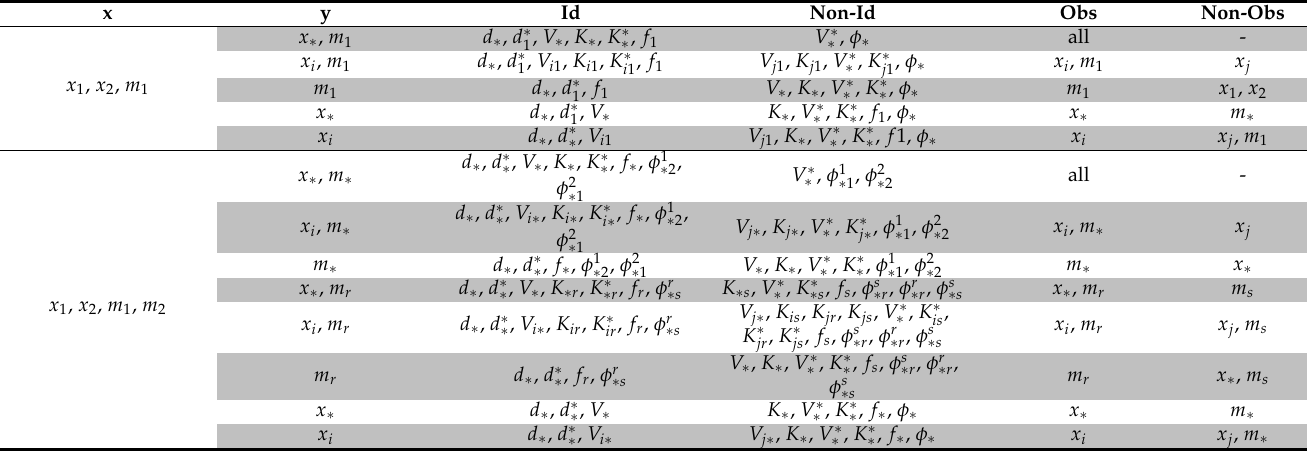
Table 4. MSMI. Results for the species–metabolite interaction models with Monod